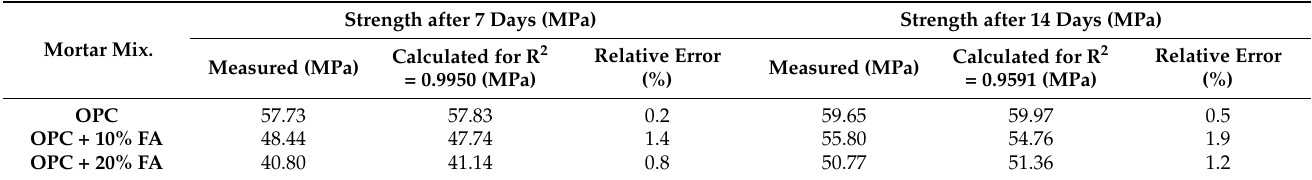
Table 6. Comparison of strength of mortar cured at 23 ◦ C.